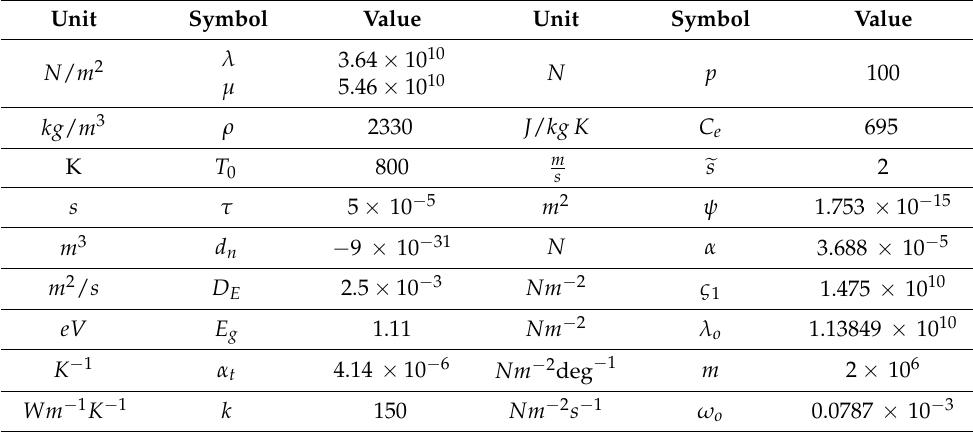
Table 1. The physical constants of Si (semiconductor)